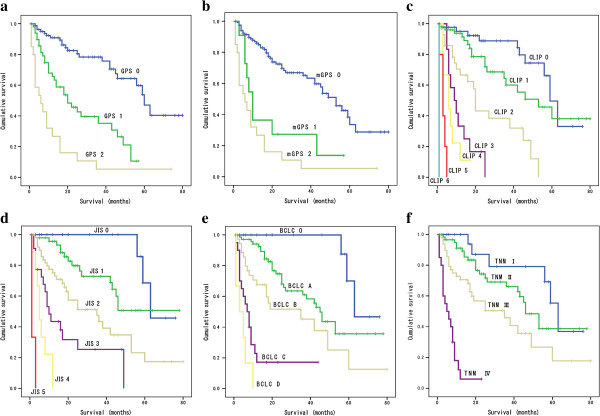
Comparison of cumulative survival according to scoring systems, GPS (a), mGPS (b), CLIP (c), JIS (d), BCLC (e), and TNM (f).